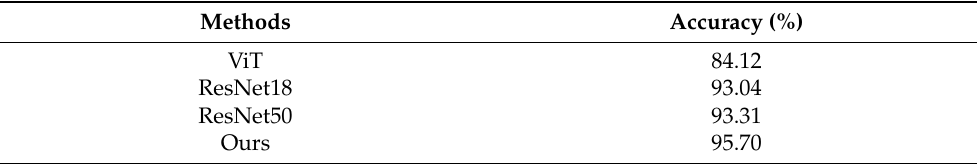
Table 4. The comparison of several classifiers in our